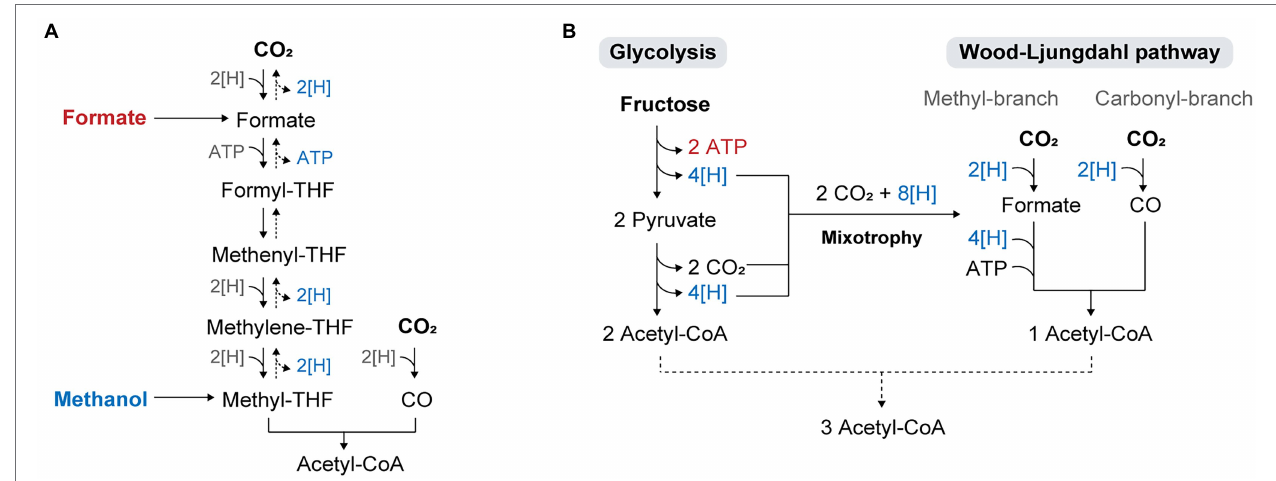
FIGURE 3 | Metabolic flexibility of acetogens utilizing diverse substrates. (A) Direct assimilation of formate and methanol into the WL pathway. (B) Concurrent utilization of Glycolysis and the WL pathway in acetogenic